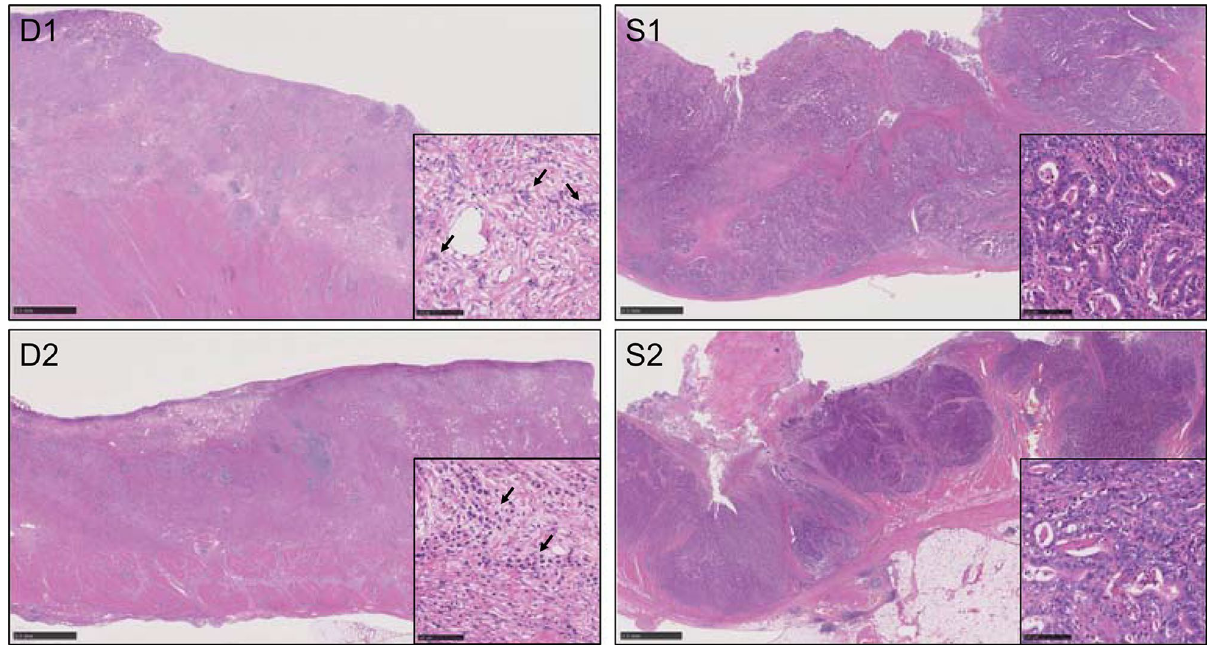
Figure 1. Hematoxylin and eosin (H&E) staining of gastric cancers used in next-generation sequencing. D1/2 and S1/2 were diagnosed as diffuse-type and intestinal gastric cancers, respectively. Scale bar represents 2.5 mm. Insets show a partial enlargement of the H&E-stained images. In the insets of the image for diffuse-type gastric cancer (D1 and D2), the areas with high density of tumor cells are indicated with black arrows. Scale bar in the inset represents 100